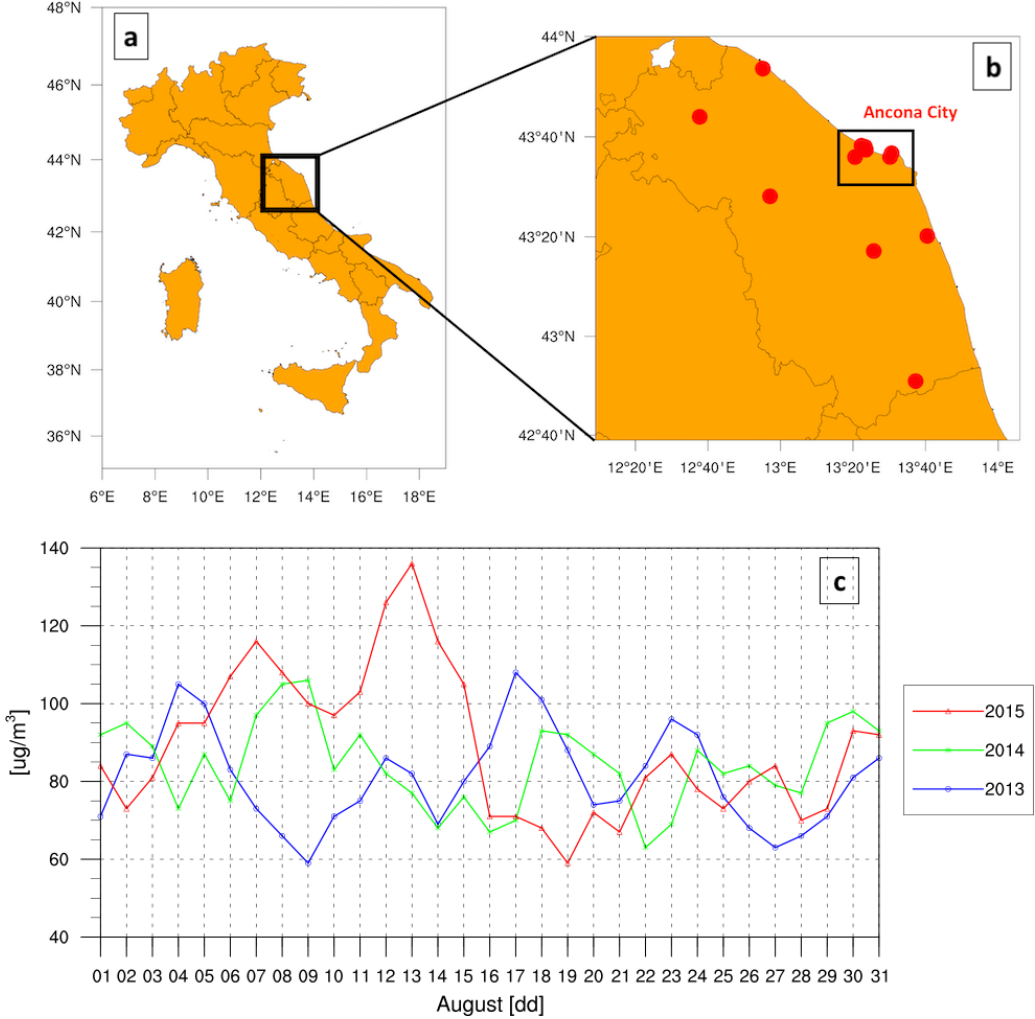
Figure 1. (a–b) Marche region (Italy) air quality monitoring stations analyzed in the 3-year study. (c) The ozone maximum daily 8h mean (µgm − 3 ) averaged over all stations (b) in the month of August 2013, 2014, and 2015 (http://85.47.105.98:16382, last access: 1 July 2021 – ARPAM).